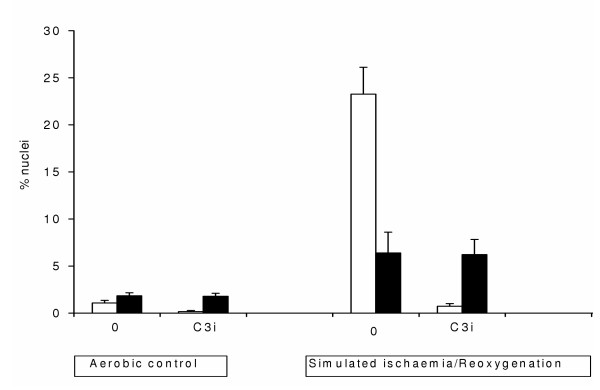
Effect of caspase-3 inhibition (C3i) with z.DEVD.FMK (70 nM) on apoptosis (empty columns) and necrosis (solid columns) in right atrial muscles subjected to 90 minutes of simulated ischaemia and 2 hours of reoxygenation. The columns represent the mean of 6 experiments and the bars represent the SEM. *p < 0.05 vs corresponding group without caspase-3 inhibitor.